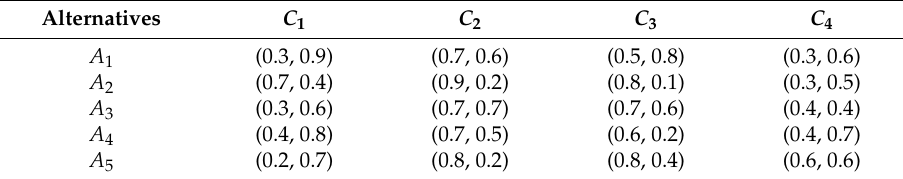
Table 2. The Pythagorean fuzzy decision matrix provided by the E 2 .